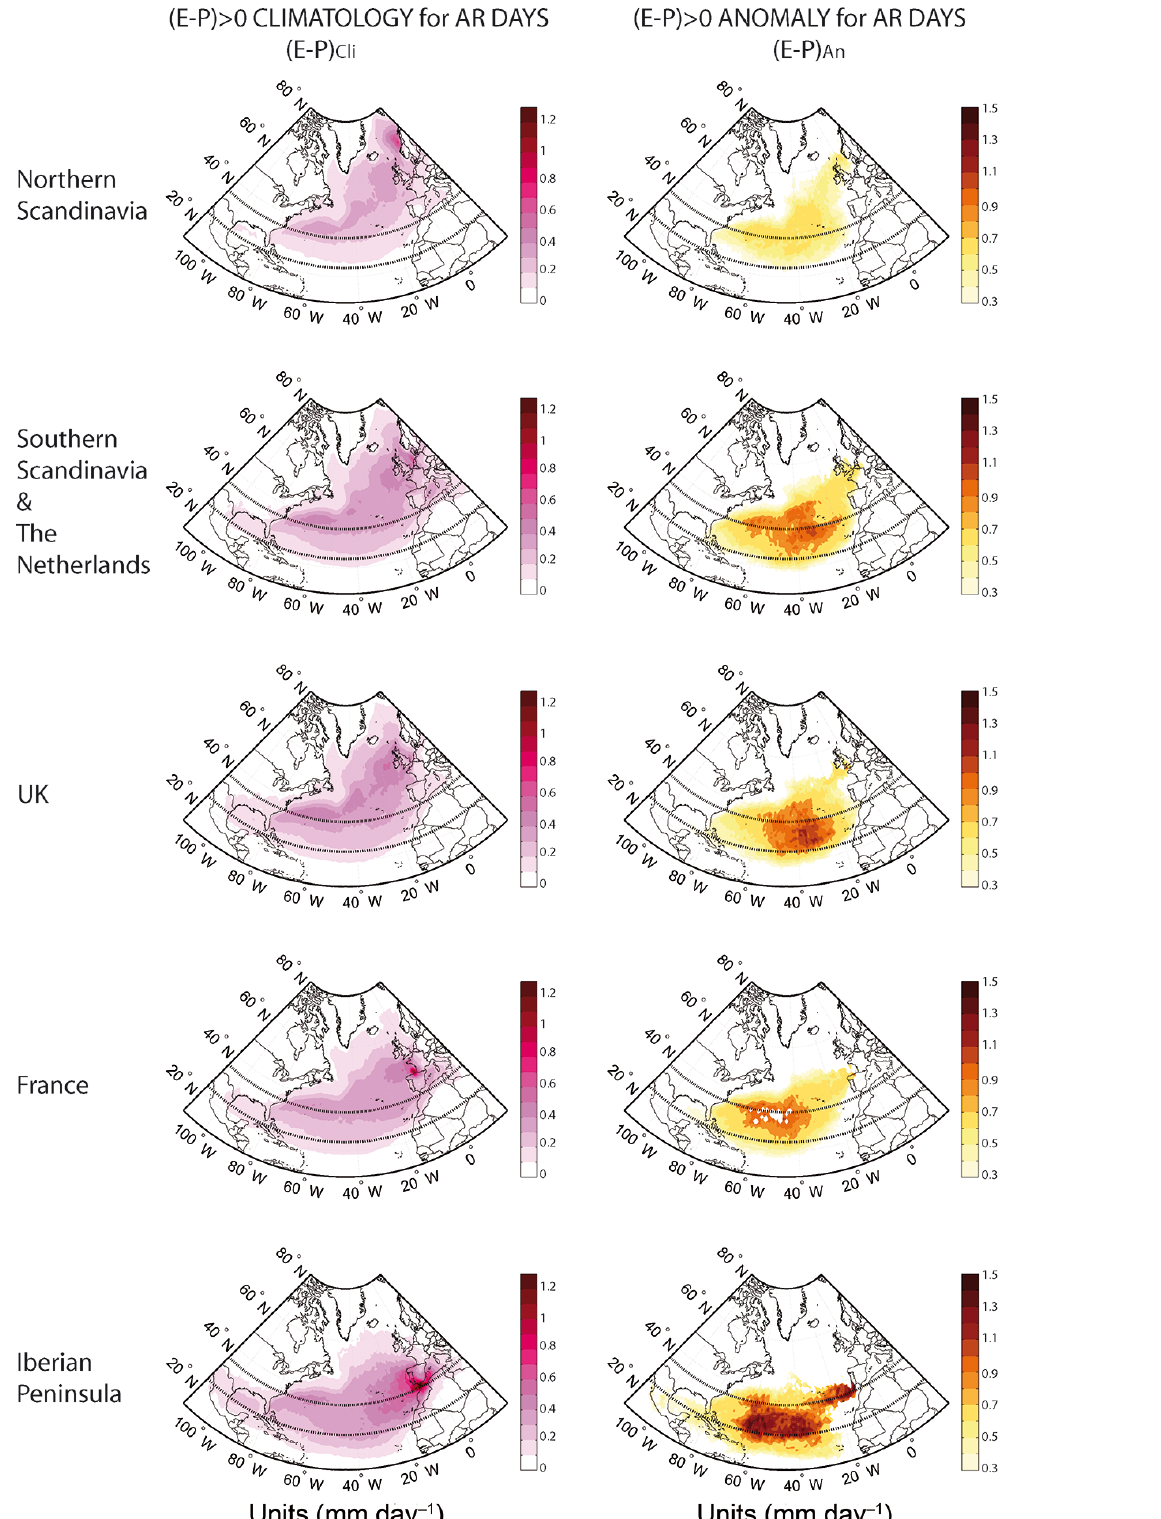
Figure 4. For each studied sink domain (Iberian Peninsula, France, UK, southern Scandinavia and the Netherlands, and northern Scandinavia) for wintertime from 1979 to 2012. Left panels: mean value of the ( E − P ) > 0 field [( E − P ) Cli ], backward integrated over a 10-day period. Right panels: ( E − P ) > 0 anomaly field for AR days [( E − P ) An ]. Units in mmday − 1 . Regarding the anomaly fields, only the results that are statistically significant at the 90% level are shown. The Tropic of Cancer parallel (23.43 ◦ N) and the 35 ◦ N parallel are also shown.